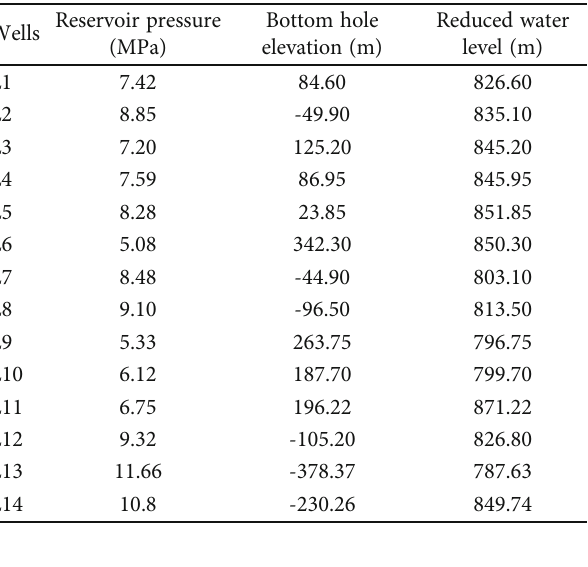
Table 3: Reduced water level of No. ( 8 + 9 ) coal seam in Yangjiapo